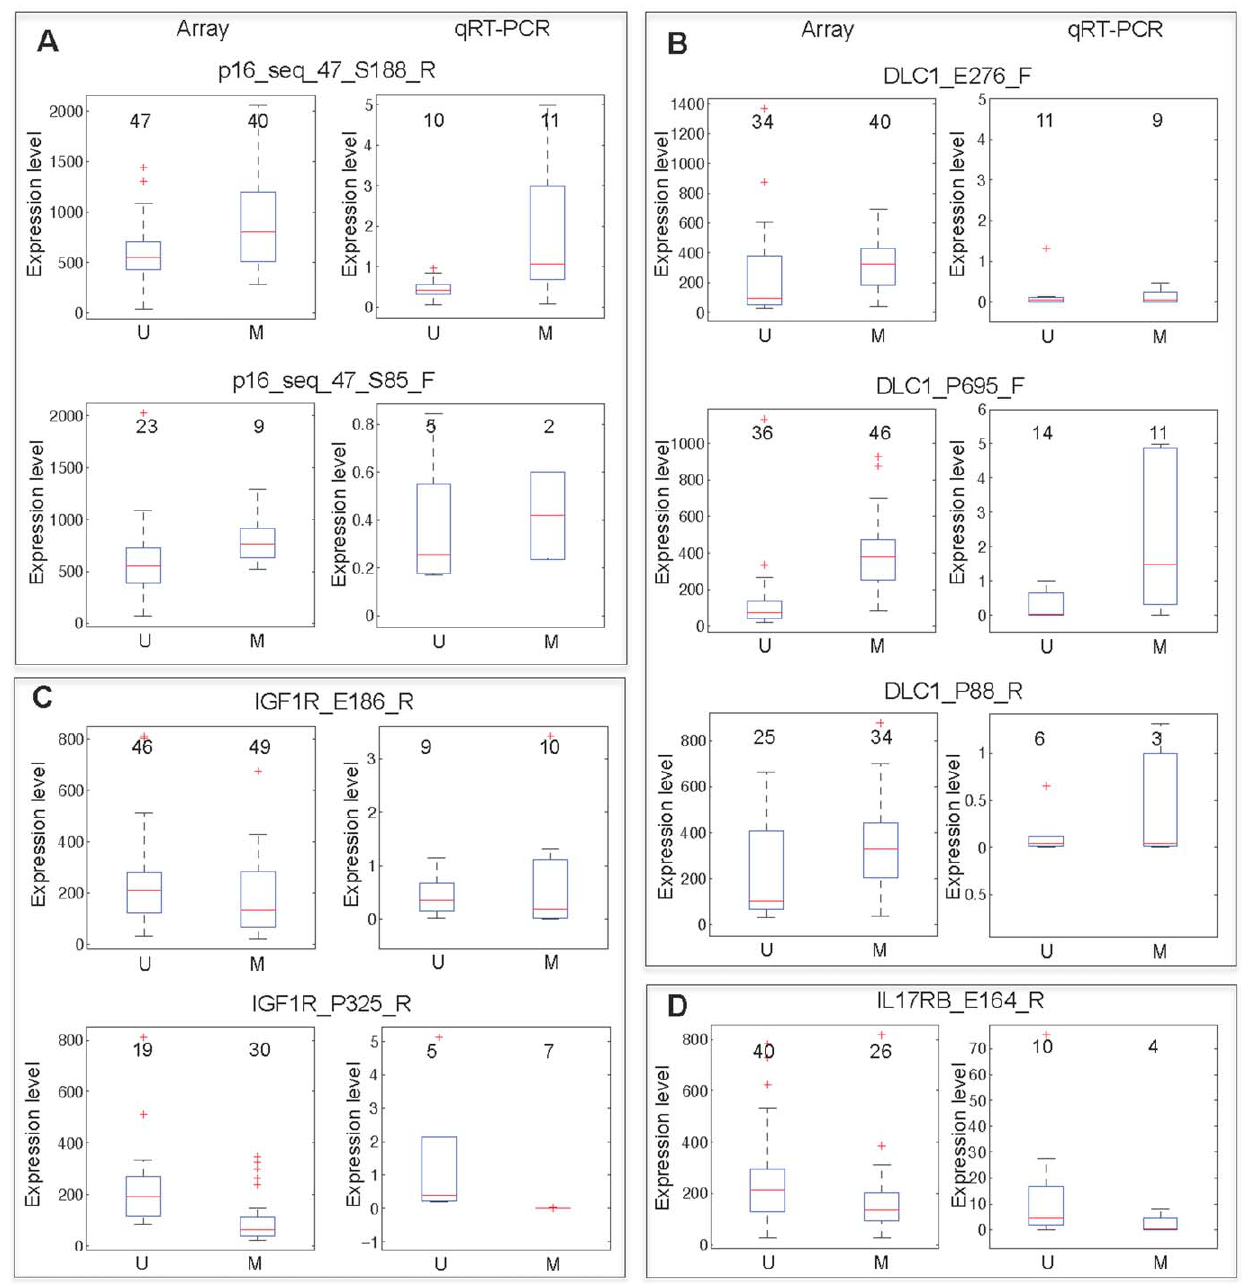
Figure 2. Confirming expression trends by qRT-PCR for correlated genes identified by discretizationapproach . Box plots represent gene expression levels generated by either microarray or qRT-PCR. Data are shown for samples classified as U or M based on the methylation status of p16 (A), DLC1 (B), IGF1R (C), or IL17RB (D). For microarray data, probe intensities are plotted on the y-axis. Relative fold-change differences are plotted for data generated by qRT-PCR. The number of samples in each group is displayed above each plot. The GoldenGate BeadArray probe names are indicated above each pair of box plots. doi:10.1371/journal.pone.0052626.g002 negative correlation trends for IGF1R and IL17RB ( Figure 5, (Figure 5C and 6C) . For DLC1, average methylation of seven CpG sites analyzed by pyrosequencing demonstrated a low 6 ). Similar to the original analysis (Table 2) , the validation correlation ( r =0.1974, P =0.1002), which was due mainly to analysis demonstrated statistically significant Pearson correlations two CpG loci (circled in Figure 6B) located in a non-CpG only for IGF1R and DLC1. IGF1R had significant Pearson island region + 143 and + 180 bp of the TSS. When these loci correlation coefficients ( r = 2 0.5390, P = 0.0001) based on the were excluded, DLC1 also showed statistically significant analysis of 8 CpG sites located about + 700– + 800 bp of the TSS correlation ( r = 0.4317, P = 0.0021) based on the remaining 5 and 24 CpG sites located about + 100– + 250 bp of the TSS